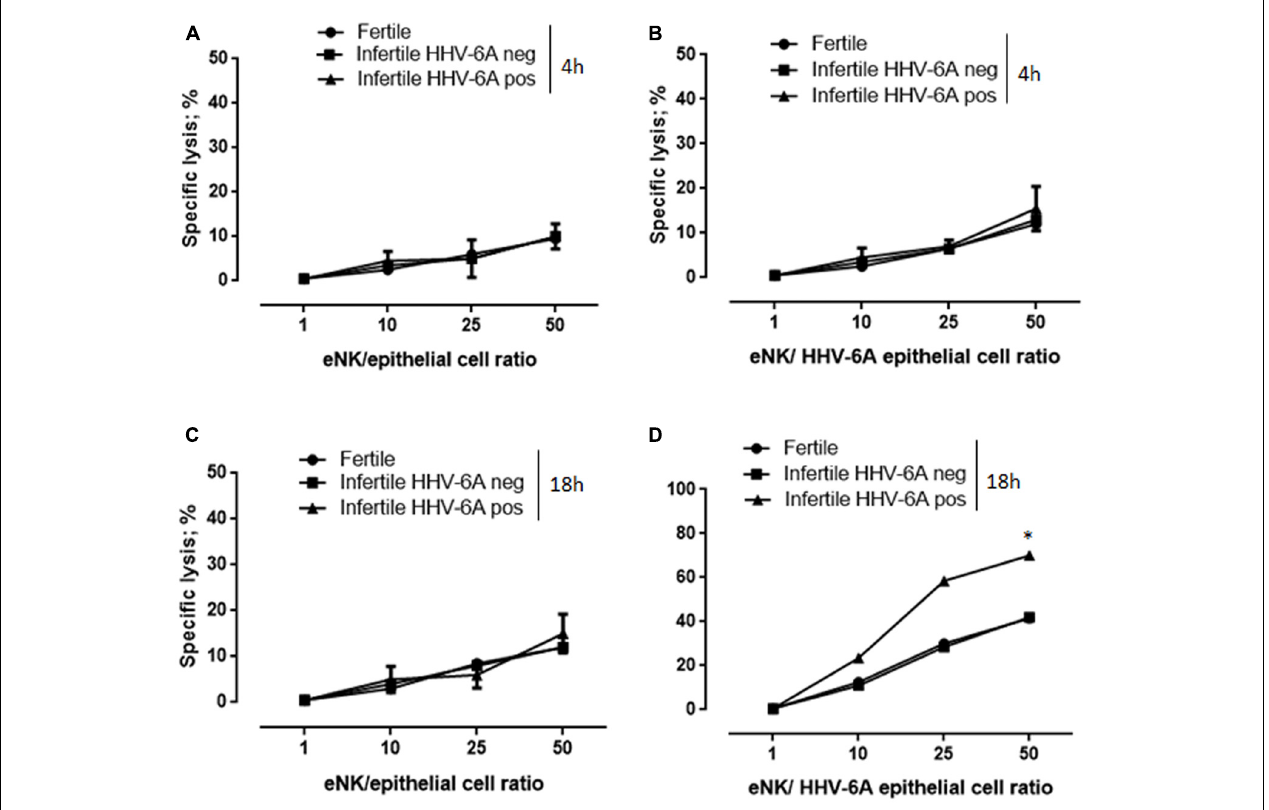
FIGURE 3 | eNK cells are cytotoxic against HHV-6A-infected endometrial epithelial cells. Endometrial epithelial cells were kept (A,C) uninfected or (B,D) infected for-48 h with HHV-6A. eNK cell cytotoxicity was determined by 7-AAD/CFSE Cell-Mediated Cytotoxicity Assay Kit after (A,B) 4 or (C,D) 18 h of contact at different E/T ratios. Each data point is calculated as the mean lysis ± SD from at least five independent experiments done in replicate tissue culture wells. ∗ Significant p -value; Student’s t